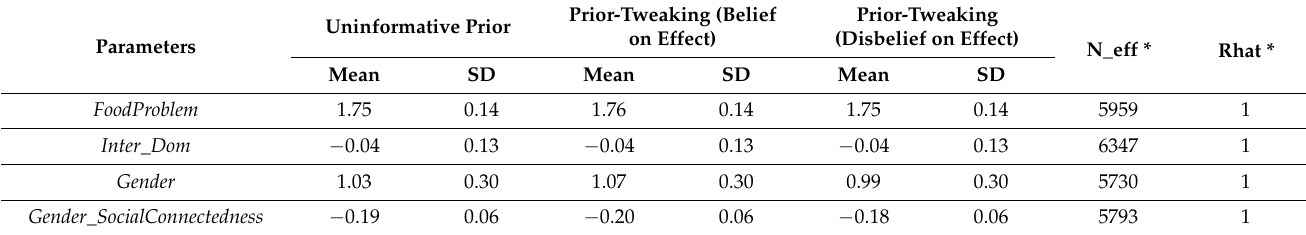
Table 2. The model’s simulated posteriors.